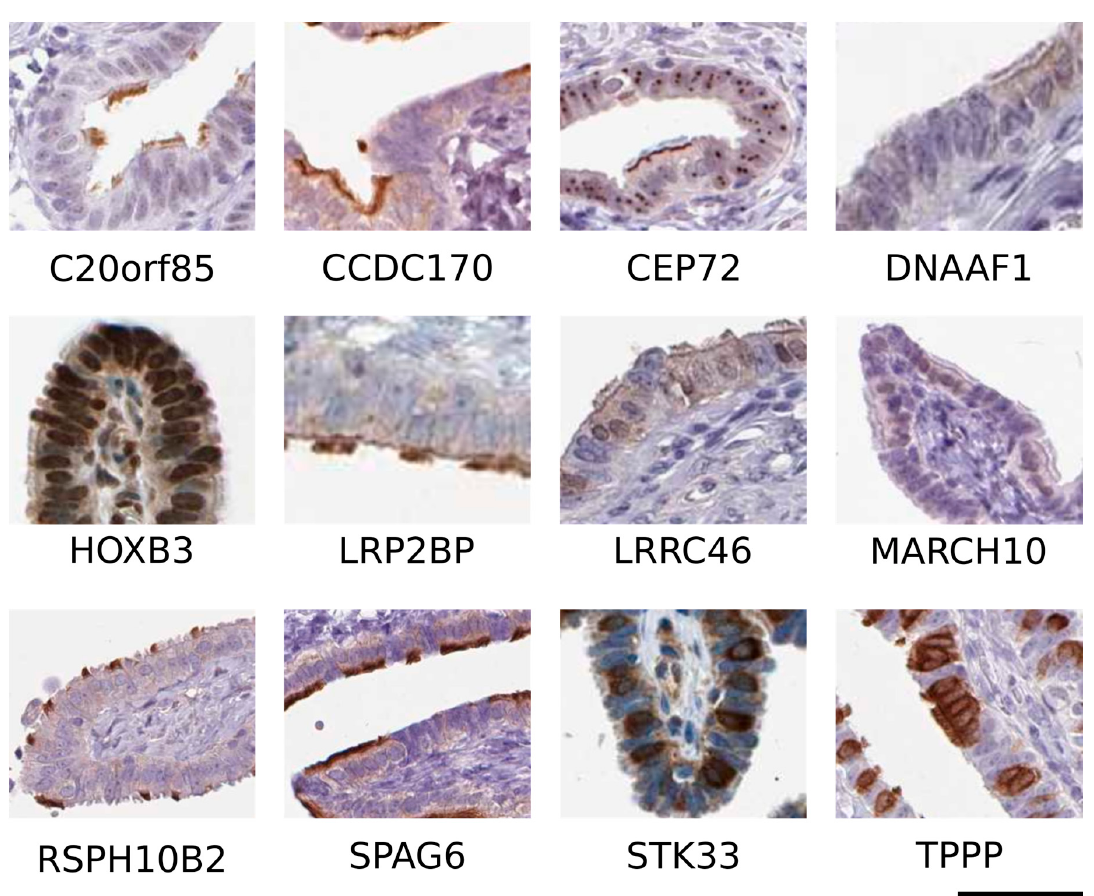
Figure 1. Representative images of immunohistochemistry staining of candidate genes from the Human Protein Atlas (HPA) database. Scale bar 50 μ m.